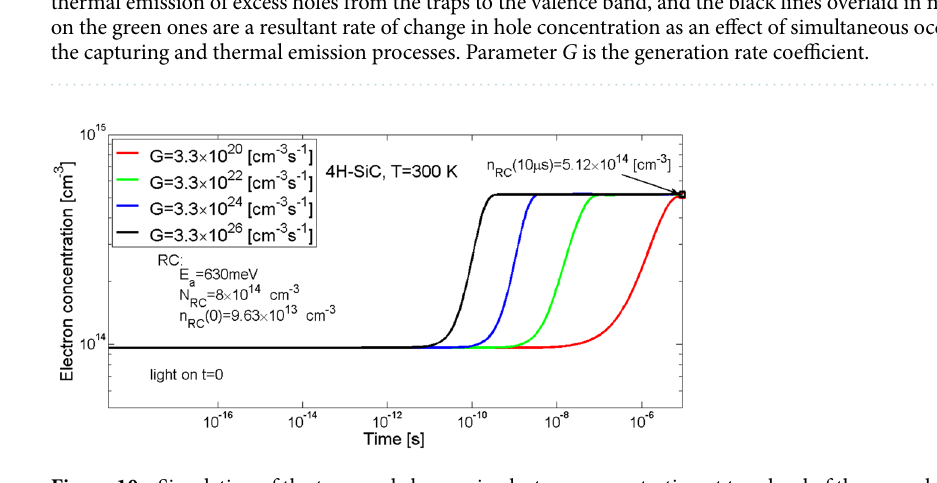
Figure 10. Simulation of the temporal changes in electron concentration at trap level of the recombination centre RC in 4H-SiC material. Parameter G is the generation rate